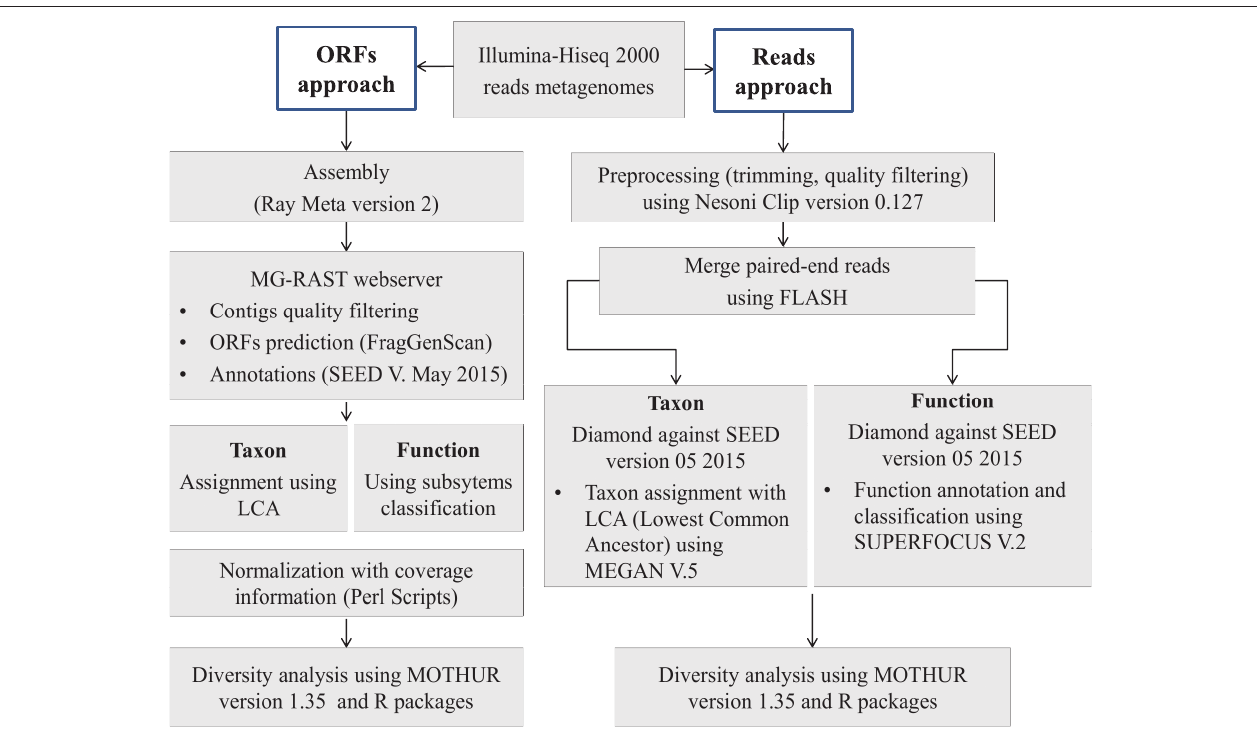
FIGURE 1 | Bioinformatics analysis pipeline. Two approaches were developed for this work. With the ORF-based approach, de novo assembly was performed on raw reads data using Ray Meta software. Then, the predicted ORFs (Open Reading Frames) were annotated using Diamond similarity research tool against SEED, which is a curated database. With the reads-based approach, merged (with FLASH algorithm) and filtered reads (with Nesoni) (length ∼ 200pb in average) were annotated using the same tool as the ORF-based approach, Diamond algorithm and SEED database. For both approaches, we used the lowest common ancestor (LCA) algorithm in the taxonomic assignment and the subsystems hierarchy in function classification. Diversity measures were computed using mothur software.